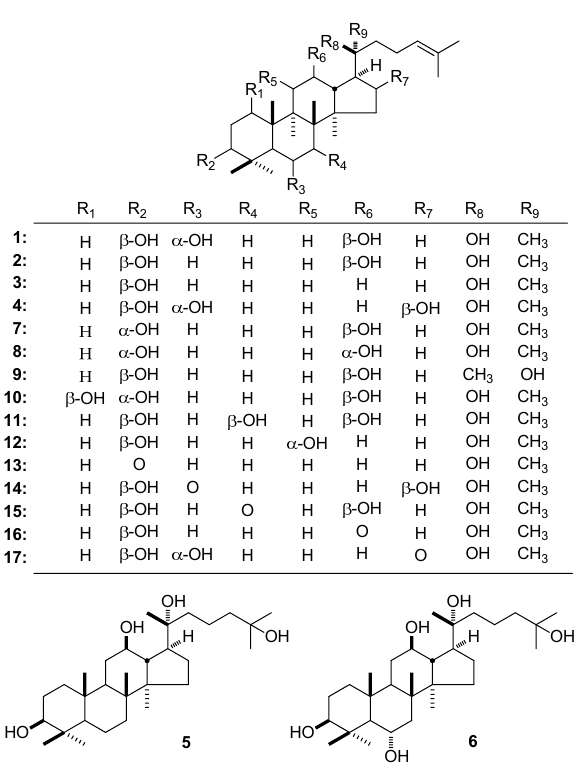
Figure 2. The structure of compounds 1 – 17 .